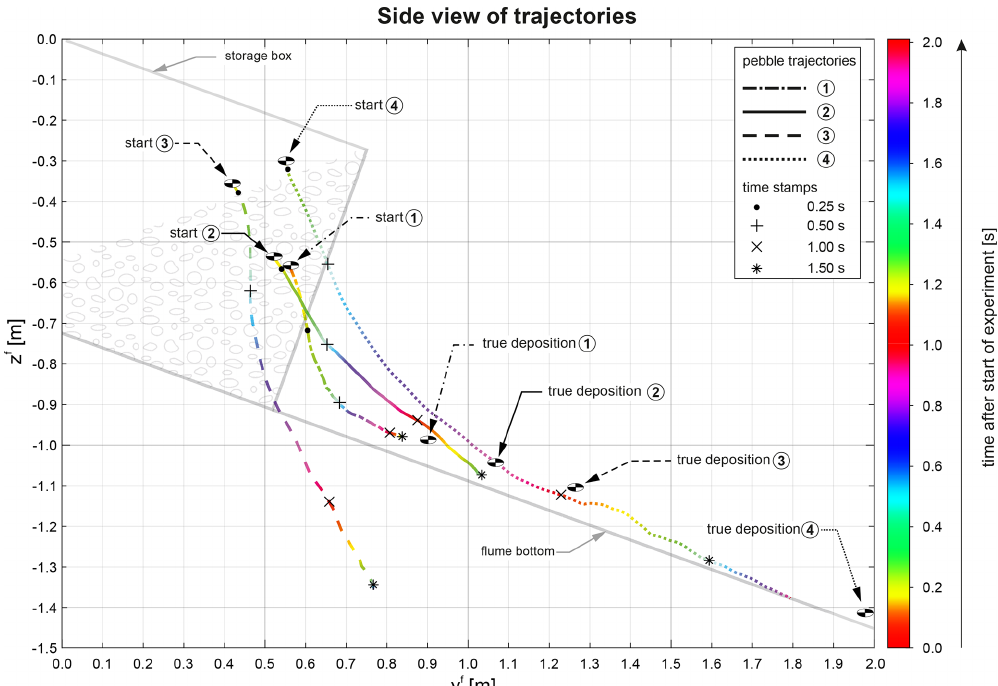
Figure 6. Reconstructed spatiotemporal trajectories and true depositional positions of four pebbles within the local flume reference system. 2D side view ( y rel z rel plane). In addition, the idealized flume construction and the pebble material body prior to the experiment are drawn in light-grey colours. Note that the equipped pebbles are not drawn to scale due to clearness reasons. The trajectories are colour-coded, where the colour represents the relative time since the start of the experiment (first motion, pebble 1). Additionally, specific points in time are highlighted by time